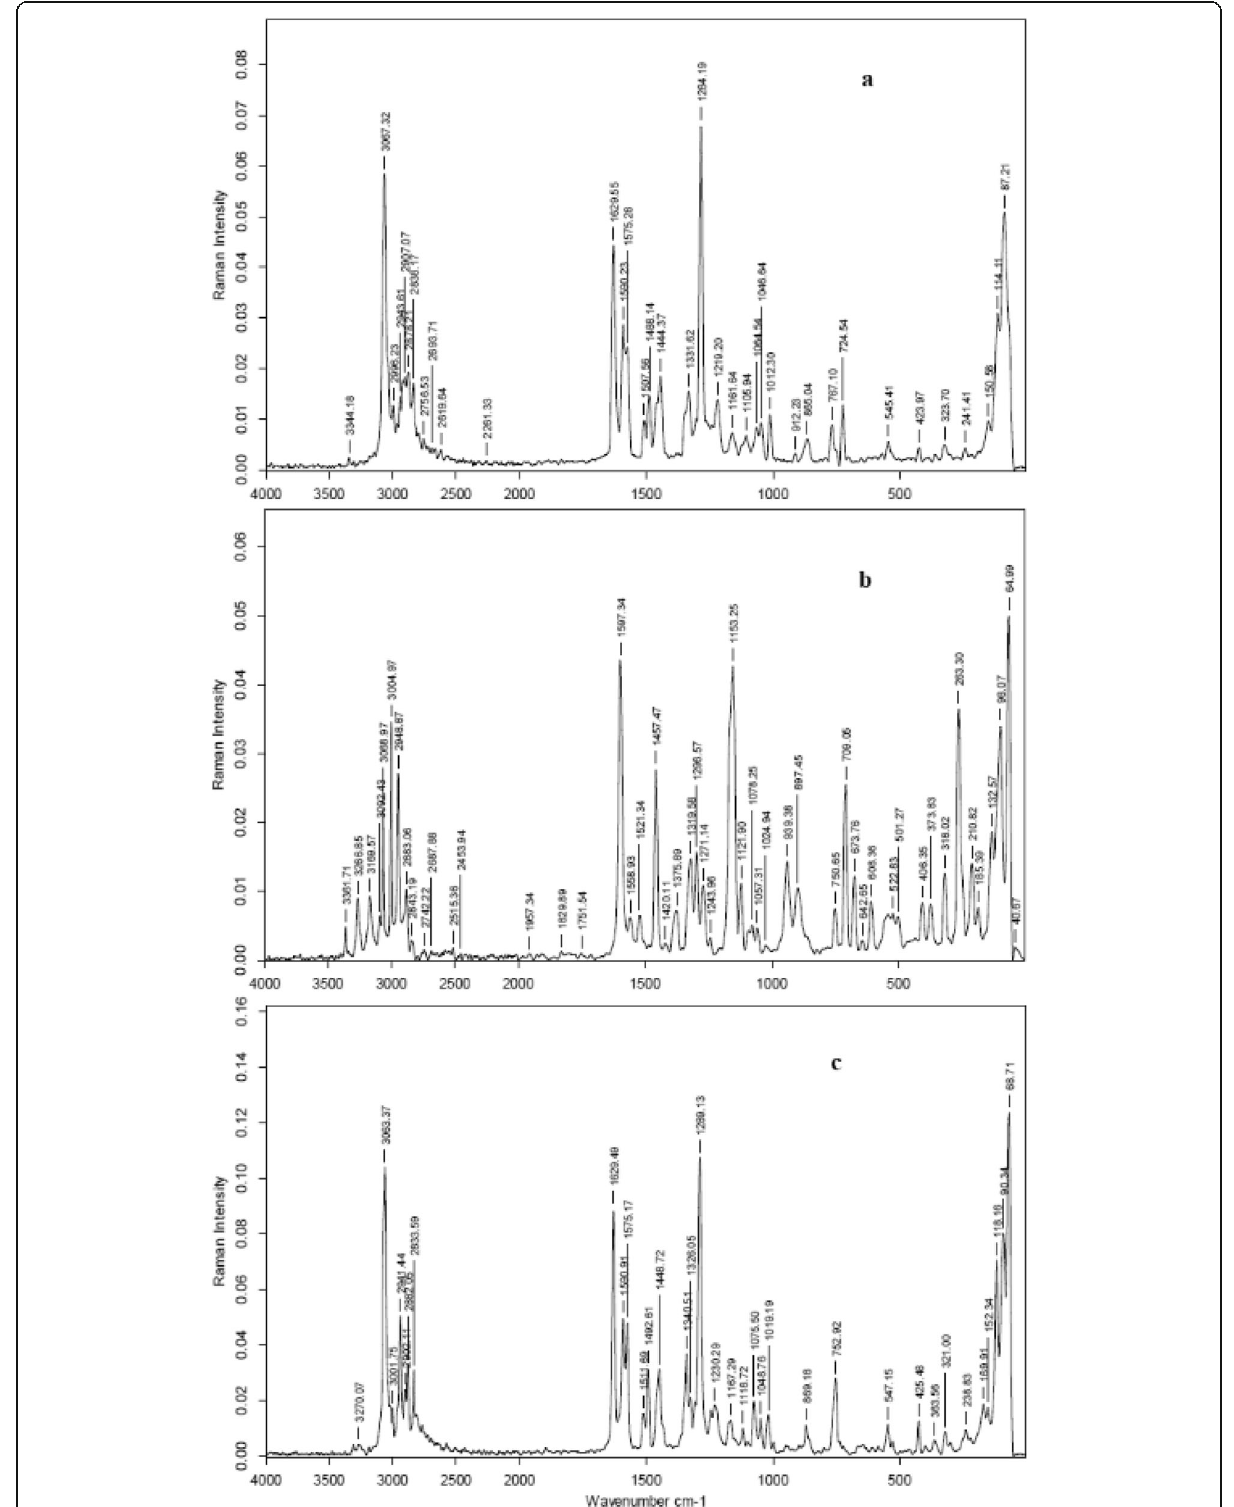
Fig. 7 a Raman spectra of CAR. b Raman spectra of HCT. c Raman spectra of